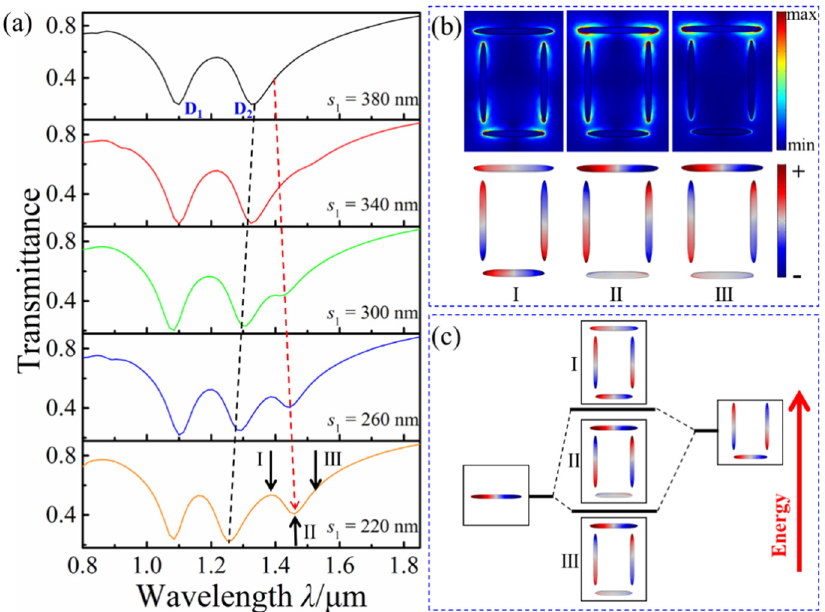
Figure 4. ( a ) Transmission spectra with the different s 1 ; ( b ) charge and electrical field distributions at positions I, II, and III; ( c ) hybrid mode scheme between the horizontal top nanorod and the remaining nanorods.